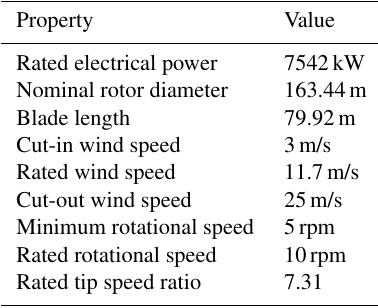
Table 1. Main turbine properties of IWT-7.5 (Popko et al.,